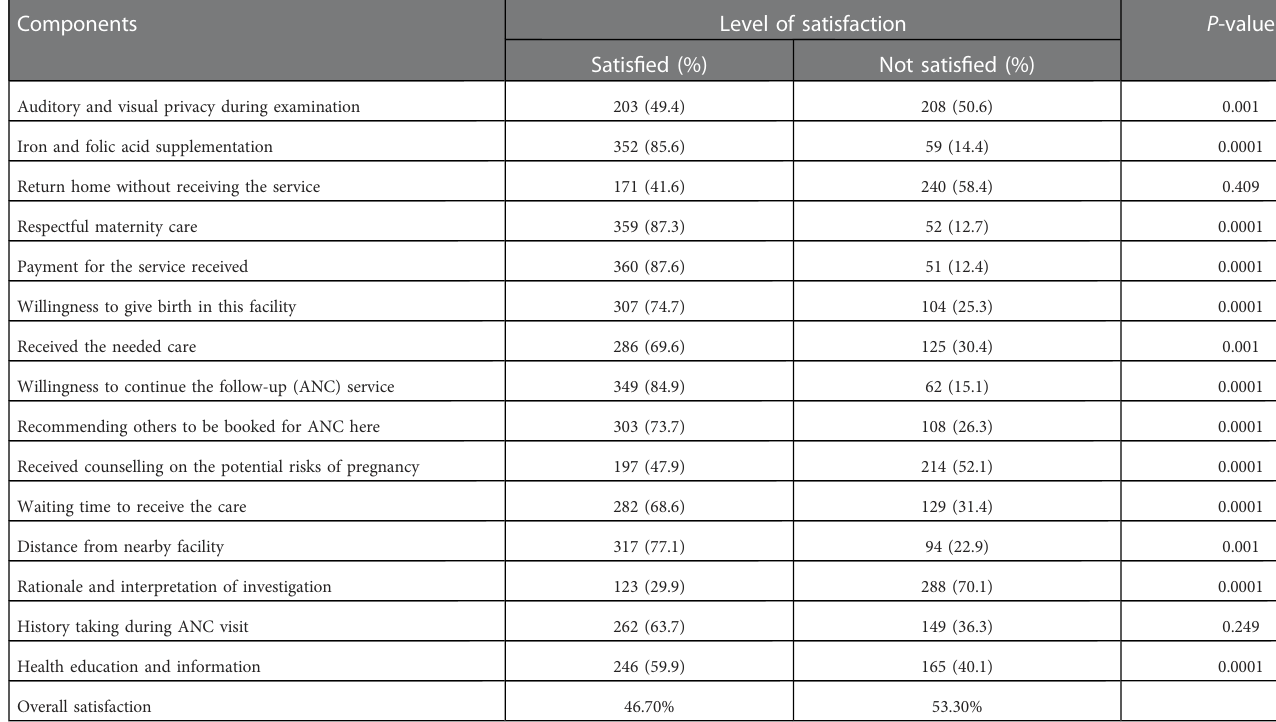
TABLE 3 Level of client satisfaction with different domains of satisfaction in public health facilities of the West Shewa Zone, Central Ethiopia ( N= 411).